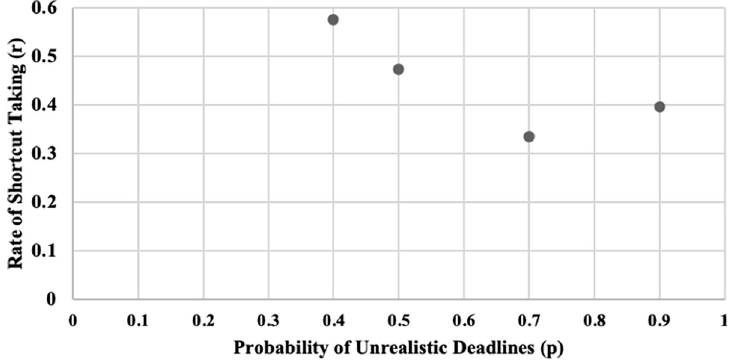
Fig 9. Relation between probability of unrealistic deadlines (p) and rate of shortcut taking (r).